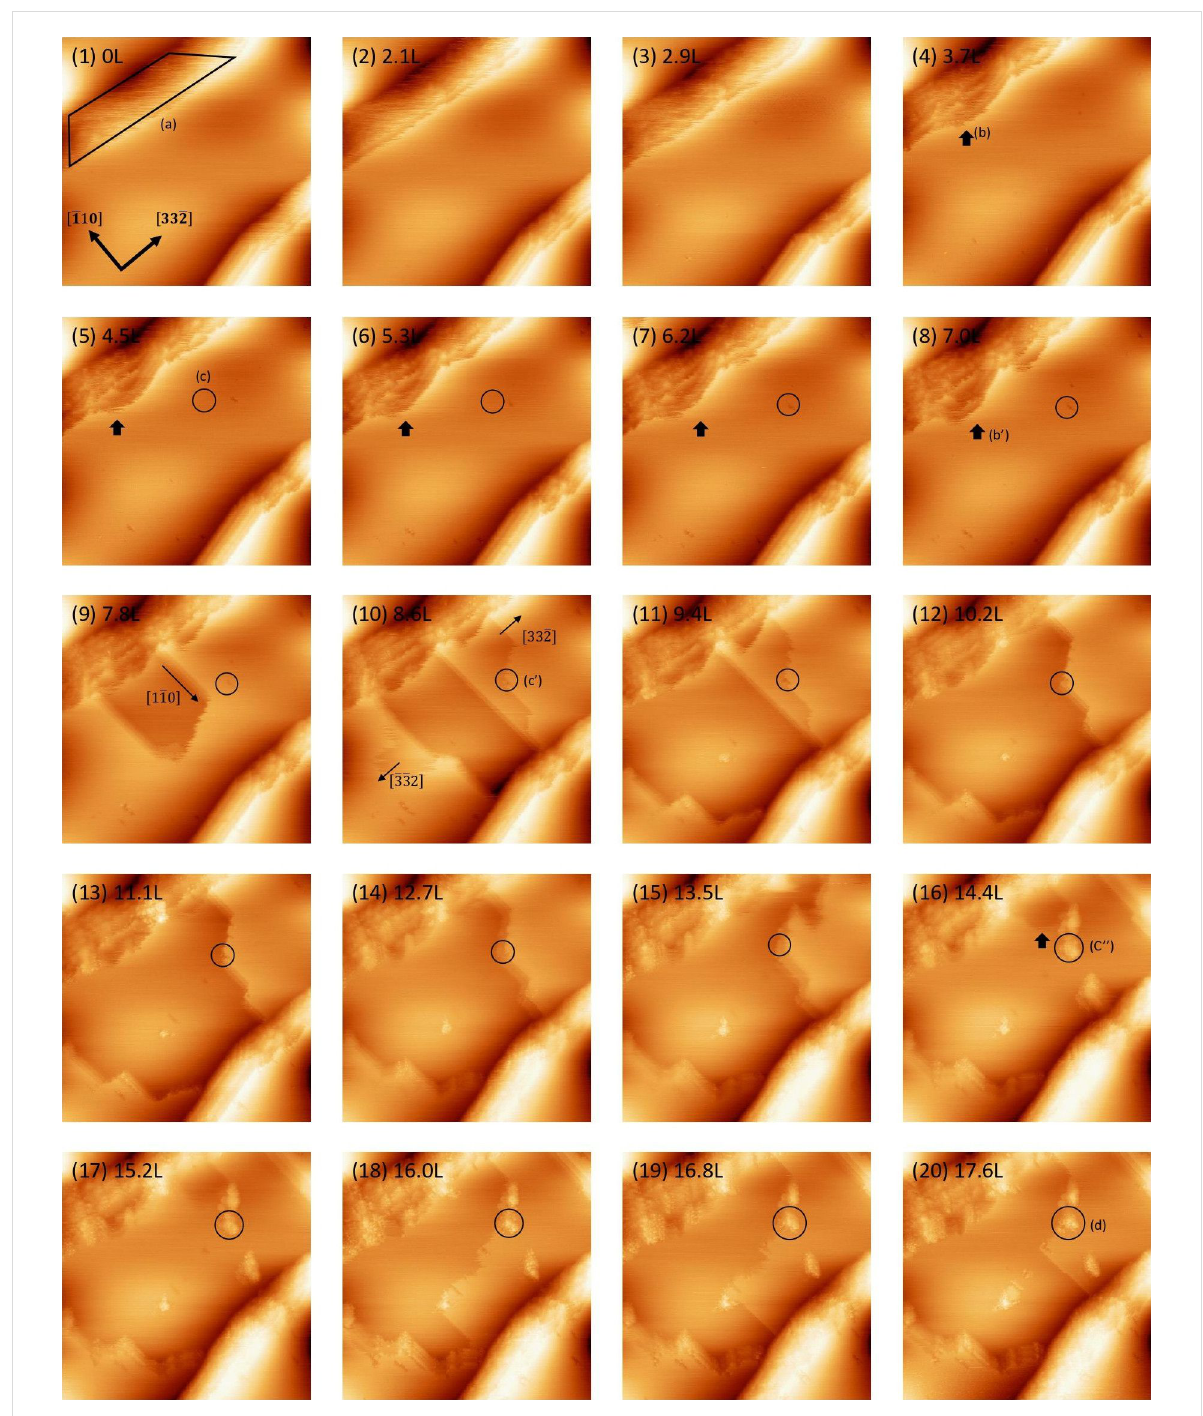
Figure 3: A series of filled-state STM images of Si(113)-(3 × 2) upon oxidation at an oxygen pressure of 1.3 × 10 − 6 Pa and a sample temperature of 820 K. A Langmuir unit is defined such that 1.0 L = 1.33 × 10 − 4 Pa·s. Image size: 100 × 100 nm 2 , V s = − 2.0 V, I t = 0.07 nA.